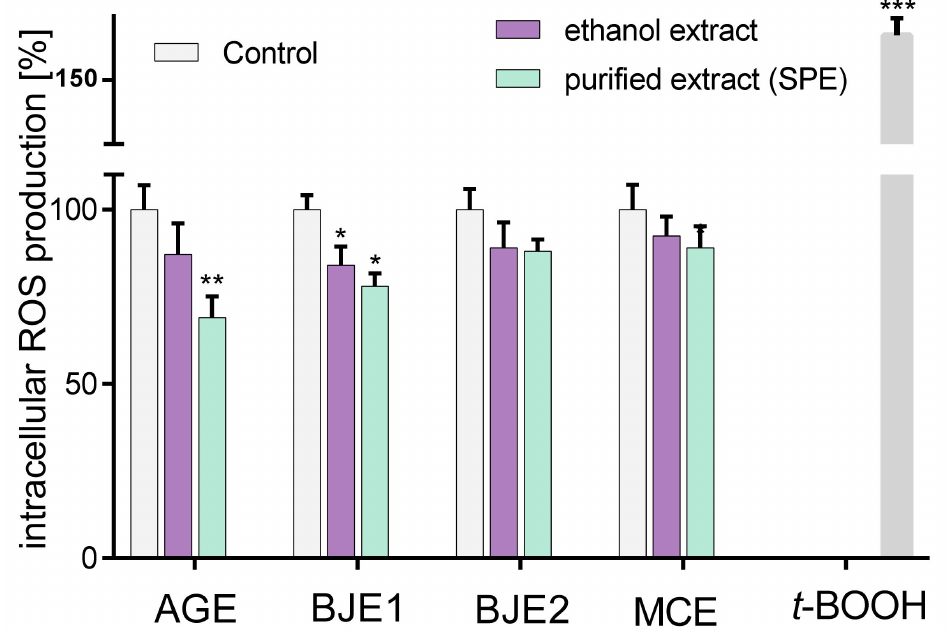
Figure 2. The influence of the ethanolic extracts and the SPE-purified extracts (p) of Apium graveolens (AGE) (A), Brassica juncea 1 (BJE1) (B), Brassica juncea 2 (BJE2) (C) and Matricaria chamomilla (MCE) (D) at 0.25 mg/mL concentration on intracellular ROS generation in Caco-2 cells after 24-h incubation, quantified with DCFH-DA assay; control cells were not exposed to any compound except vehicle; values are means ± standard deviations from at least three independent experiments, n ≥ 9; statistical significance was calculated versus control cells (untreated) with * p ≤ 0.05, ** p ≤ 0.01, *** p ≤ 0.001; 500 µ M t-BOOH was used as positive